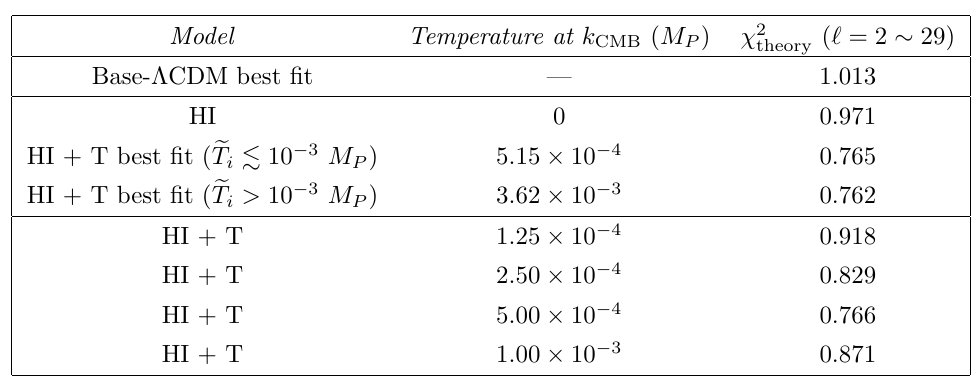
Table 2 . (cid:31) 2 values for di(cid:11)erent models using the Planck 2018 data [56]. The HI and HI + T denote the standard Higgs in(cid:13)ation and the Higgs in(cid:13)ation starting with a (cid:12)nite temperature,